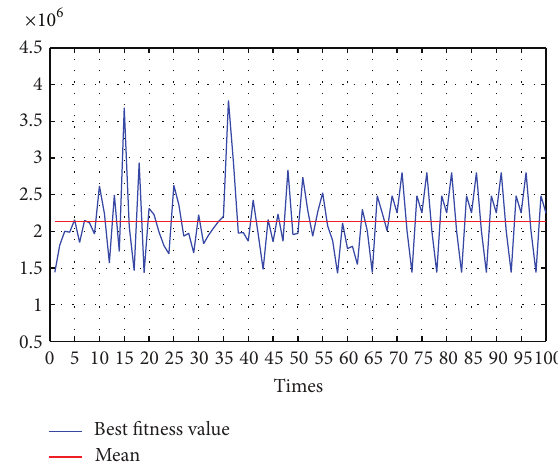
Figure 11: The fluctuation curve of optimal objective function value by